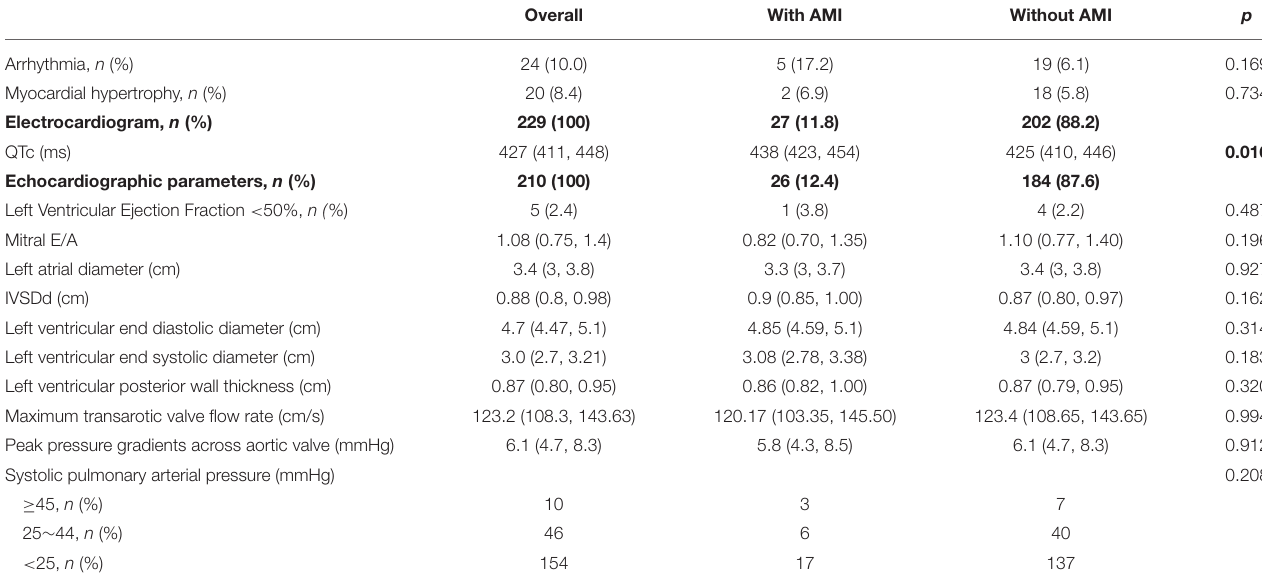
TABLE 3 | Comparison of cardiac manifestations between APS with and without AMI.